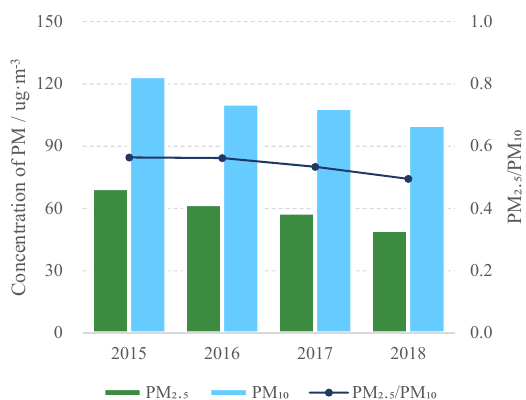
Figure 2. Temporal variation in the annual mean values of atmospheric particulate matter concentration. The spatial distribution of the annual mean particle concentration was obtained with the spatial interpolation method, and the results are shown in Figure 3. Overall, the trend of PM concentration in the study area was high in the southeast and low in the northwest. The overall concentrations in Chengde, Zhangjiakou and other cities in the north were low, while those in Beijing, Tianjin and other central cities were slightly higher. Relatively high values were mostly concentrated in Xingtai, Hengshui, Handan, Shijiazhuang, Baoding and other cities in the south.